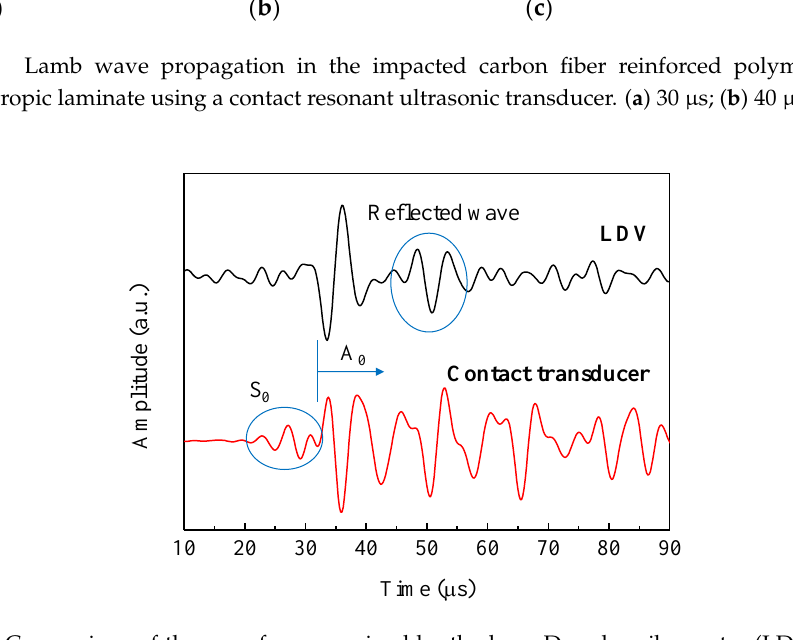
Figure 8. Comparison of the waveforms received by the laser Doppler vibrometer (LDV) and the contact transducer when pulsed laser illuminated at the black dot in Figure 7a.